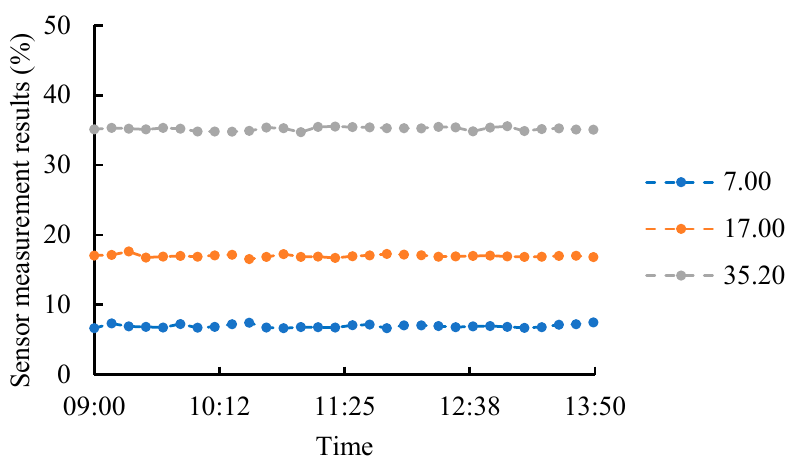
Figure 9. EEMFI sensor measurement stability analysis.